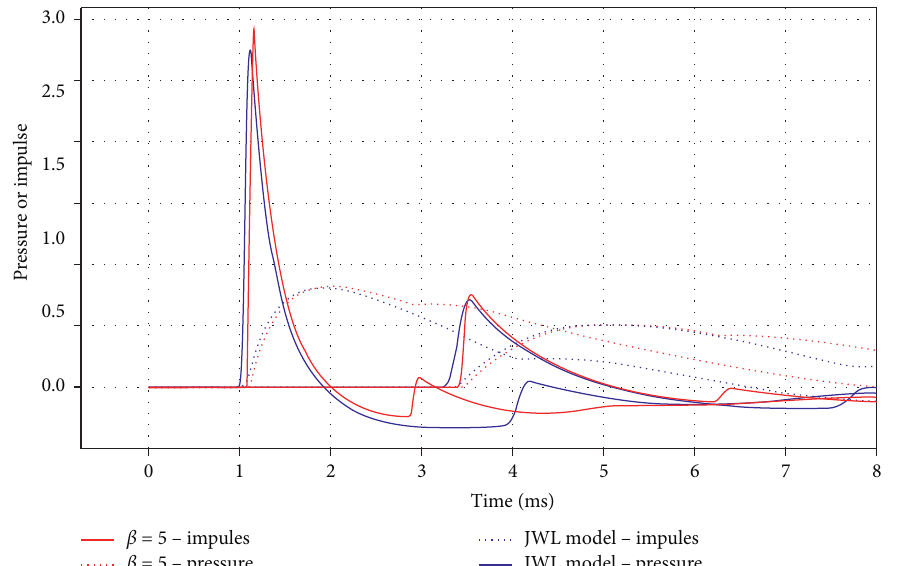
Figure 7: Temporal evolution of overpressure and impulse for both JWL and β � 5 models at two scaled distances: 1.4 and 2.6 m · kg − 1 / 3 .